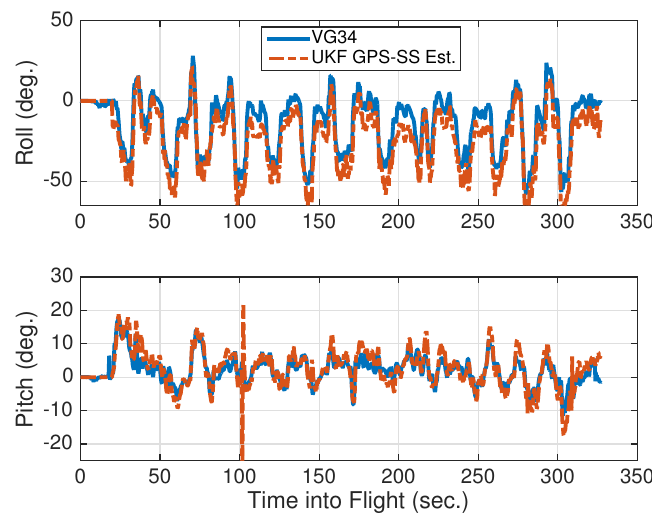
Figure 4. Comparison of GPS signal strength based attitude estimate and mechanical gyroscope measurements. Note that pitch and roll are plotted on different